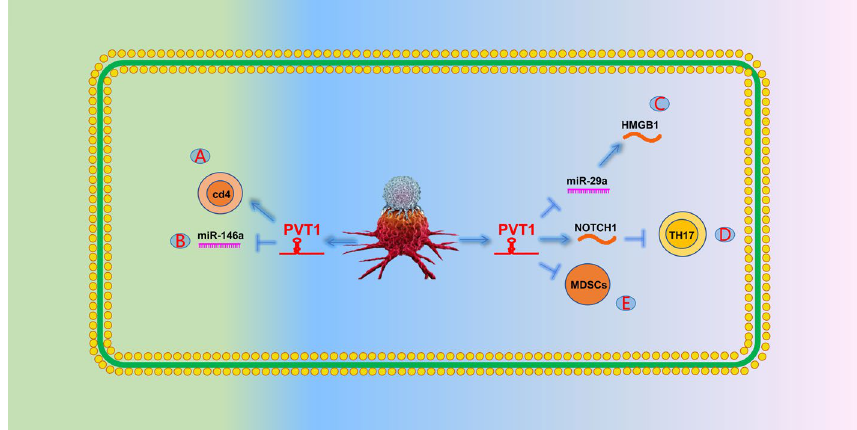
Fig. 7 The role of PVT1 in the immune system. A PVT1 can activate CD4 + T cells. B PVT1 can promote autophagy of regulatory T cells by targeting miR-146a. C PVT1 can promote the expression of HMGB1 and promote the polarization of M1 macrophages by targeting miR-29a. D PVT1 can reduce TH17 differentiation by attenuating NOTCH1 expression. E PVT1 can promote the effect of MDSCs to achieve tumor immune